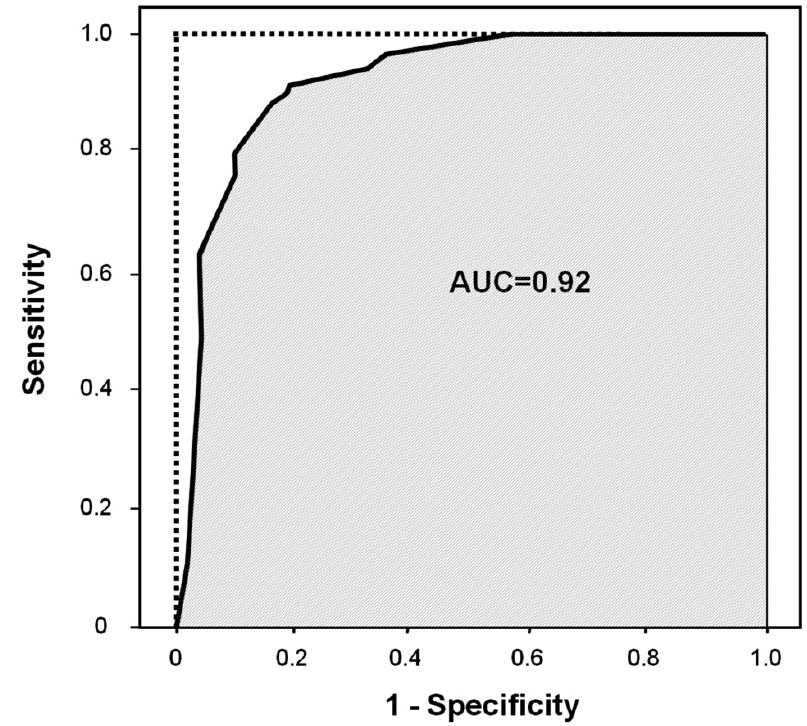
Figure 1. “Sensitivity” vs. “1-Specificity” plot. Solid line represents the calculated Receiver Operating Characteristic (ROC) curve, which indicates the discrimination capability of the LRM. Dotted line represents the perfect ROC curve (Area under the curve [AUC] = 1). Non-resistant cases wrongly classified by the model (false positives) are represented in the x -axis (1-Specificity). Resistant cases correctly classified by the model (true positives) are represented in the y -axis